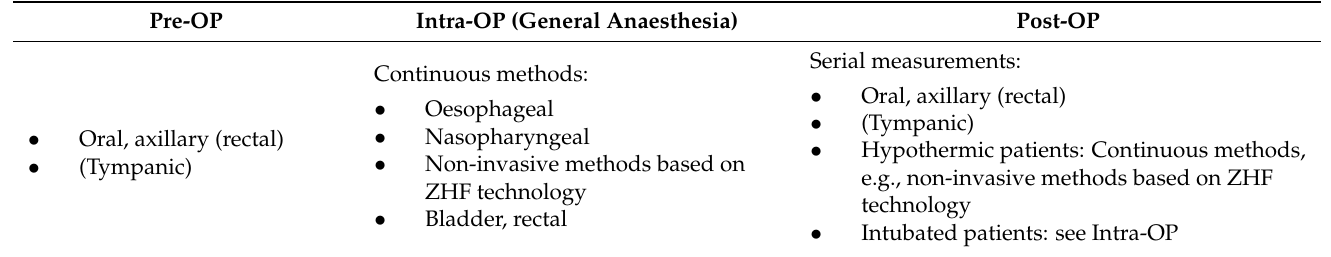
Table 2. Recommendations on core temperature